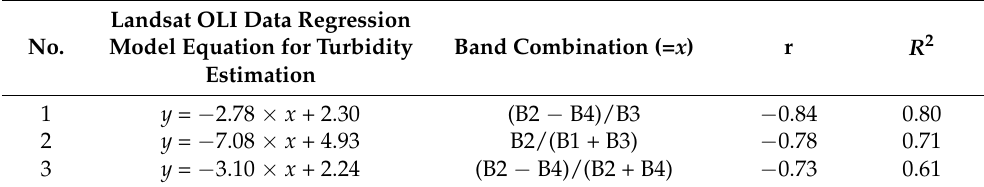
Table 10. Regression model for the retrieval of turbidity concentration using Landsat OLI training datasets.